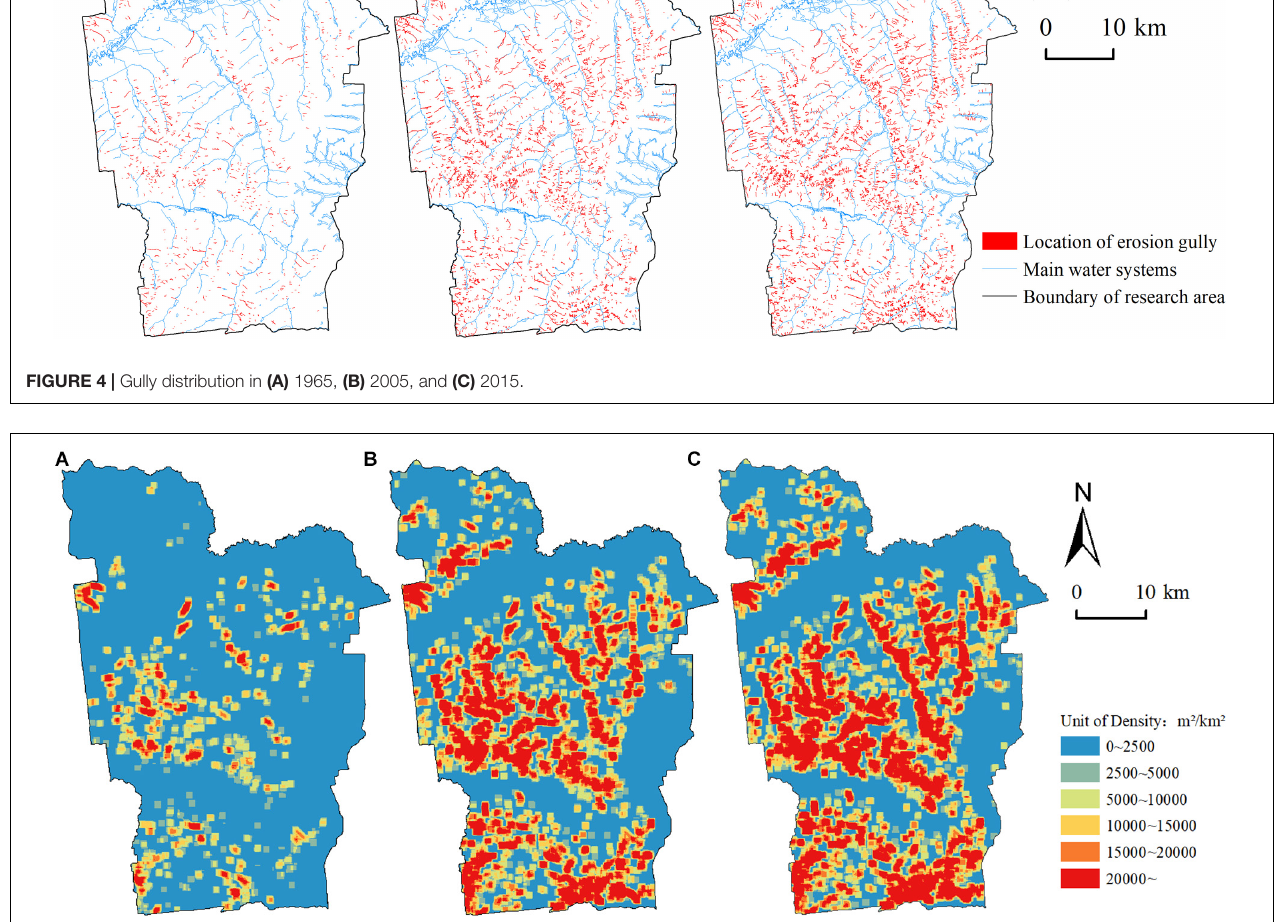
FIGURE 5 | Gully density distribution in (A) 1965, (B) 2005, and (C)